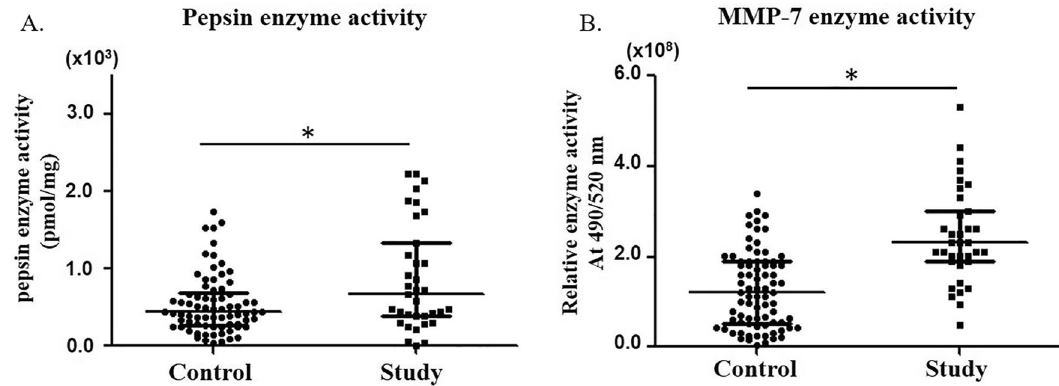
Figure 2. Enzyme activities of pepsin and MMP-7 in control and study groups. ( A ) Pepsin. ( B ) MMP-7. Horizontal bars represent median value (central horizontal bar) and 25th and 75th percentile values (lower and upper bars) for each group.